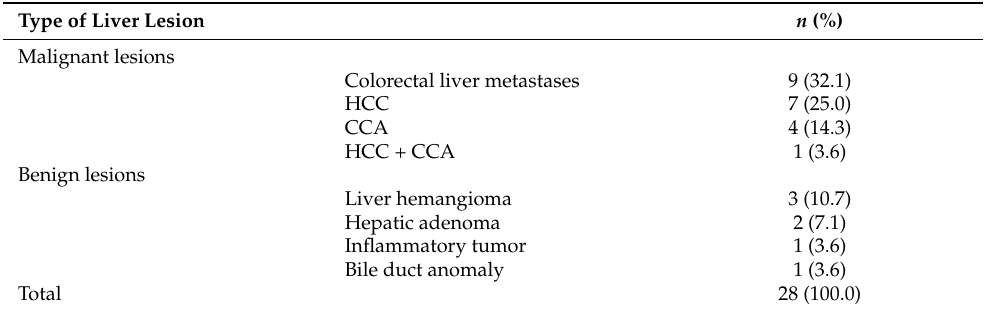
Table 3. Liver tumor pathology in patients who underwent major and minor robotic liver resection (RLR) using the three device (3D) technique for parenchyma dissection.